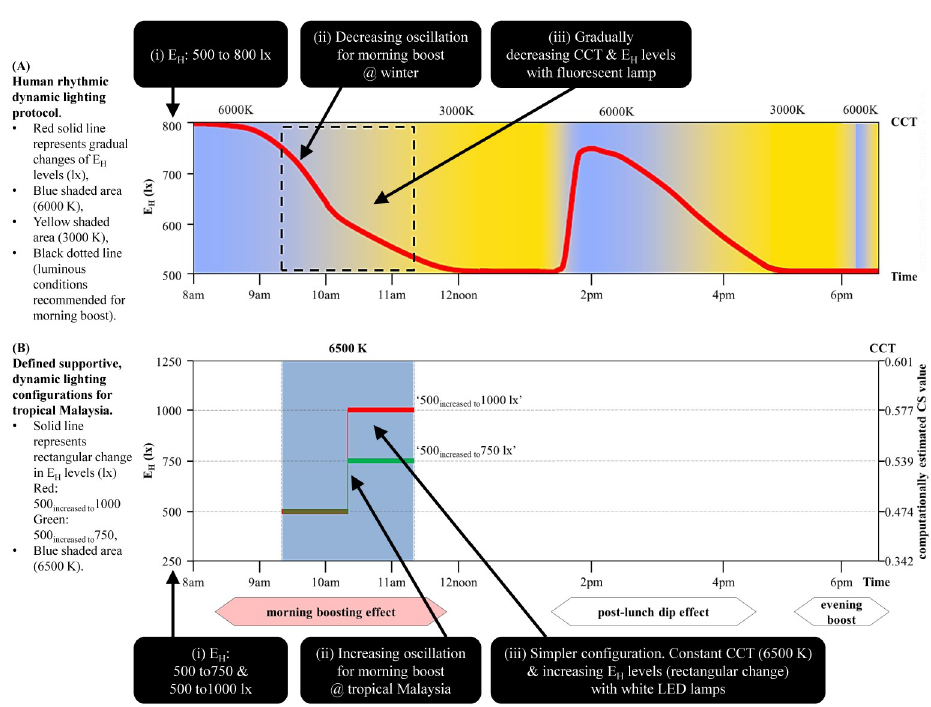
Fig 10. Key differences in the luminous conditions for boosting effect during the peak morning work period. (A) Human rhythmic dynamic lighting protocol by van Bommel [11,12].(B) Defined supportive, dynamic lighting configurations for tropical